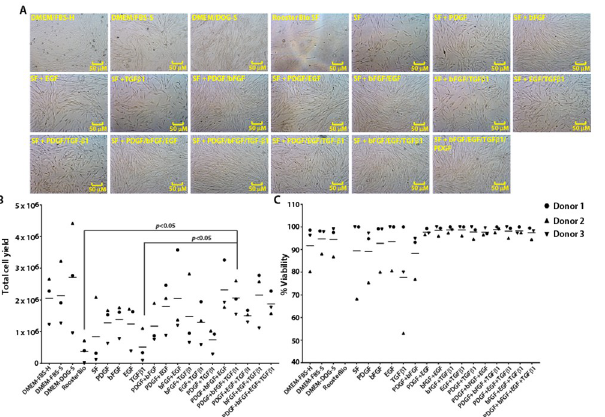
Fig 3. Identification of growth factors required for expansion of canine Ad-MSCs under serum-free conditions. A . Photomicrographs of canine Ad-MSCs cultured in serum-free medium with or without growth factors or DMEM/ FBS-H or DMEM/FBS-S or DMEM/DOG-S. B & C . Cell number and viability were determined a week after placing in serum-free medium containing indicated growth factors or DMEM/FBS-H or DMEM/FBS-S or DMEM/DOG-S. Means of two replicates for each donor are shown.